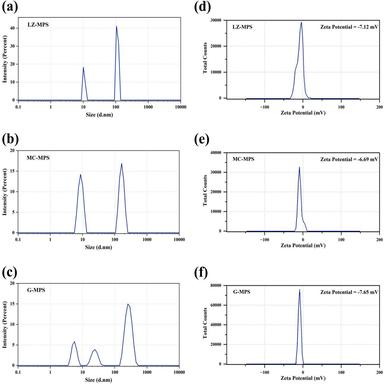
Particle size distribution (a–c) and apparent zeta potential profiles (d–f) of LZ-MPS, MC-MPS, and G-MPS in ultra-pure water (1 mg/mL) at 25 ◦C.